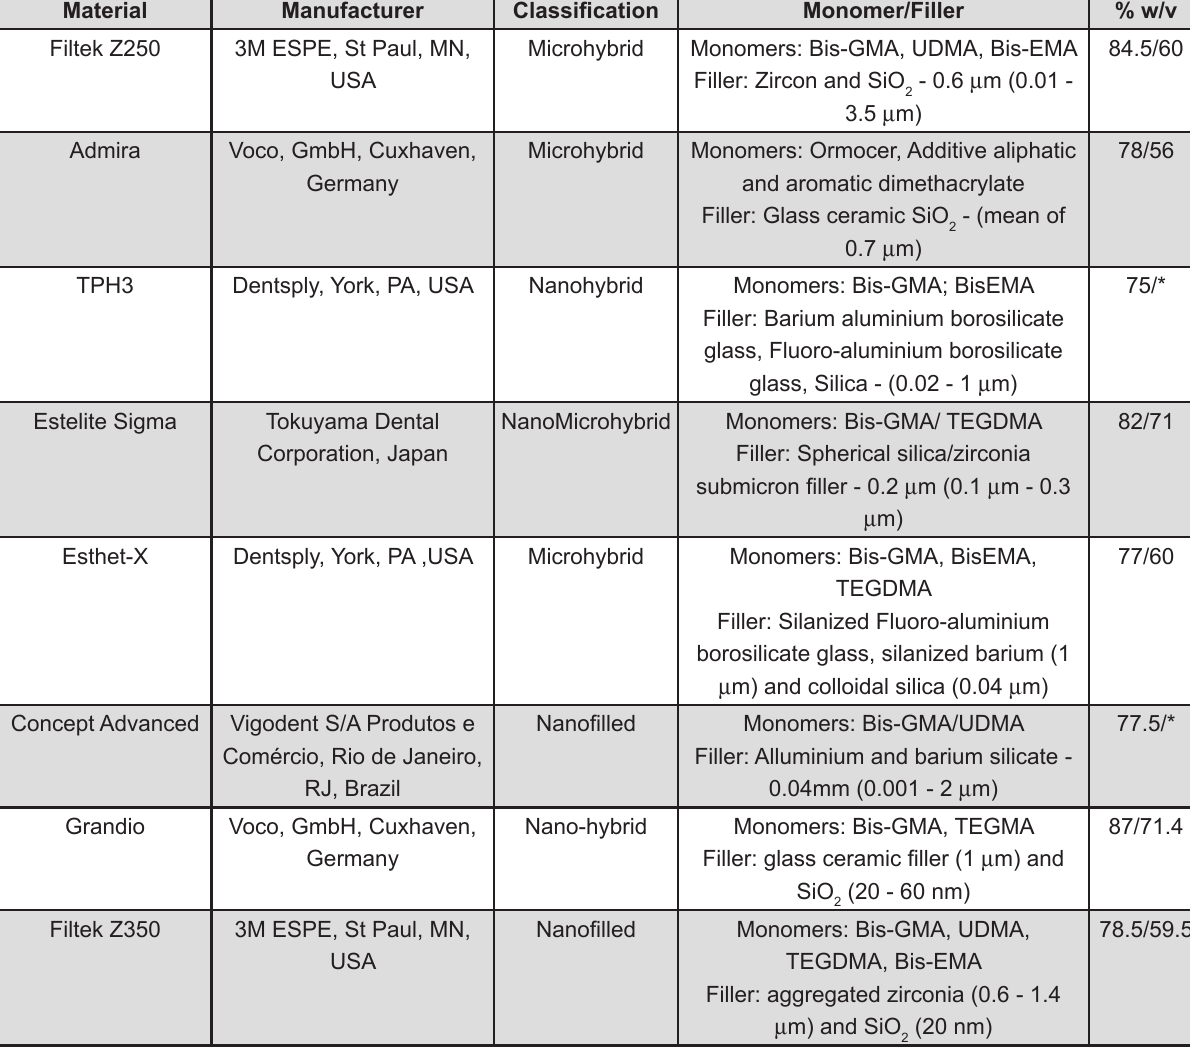
Figure 1- Information of tested composite